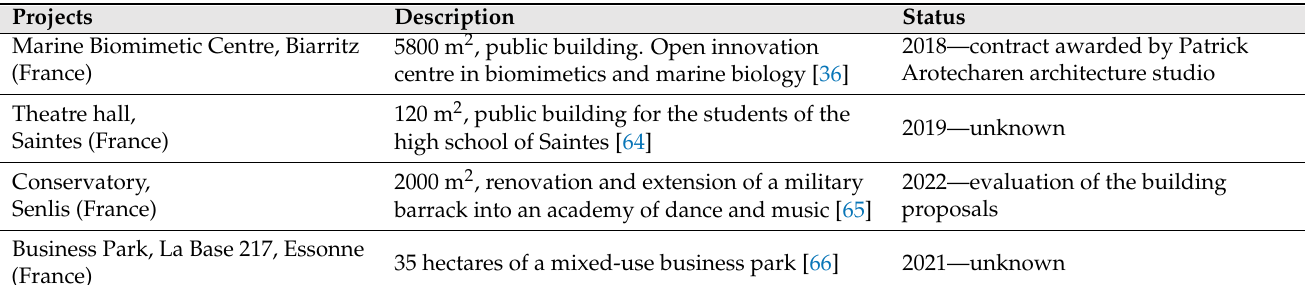
Table 3. Four calls for projects integrating biomimicry and regenerative